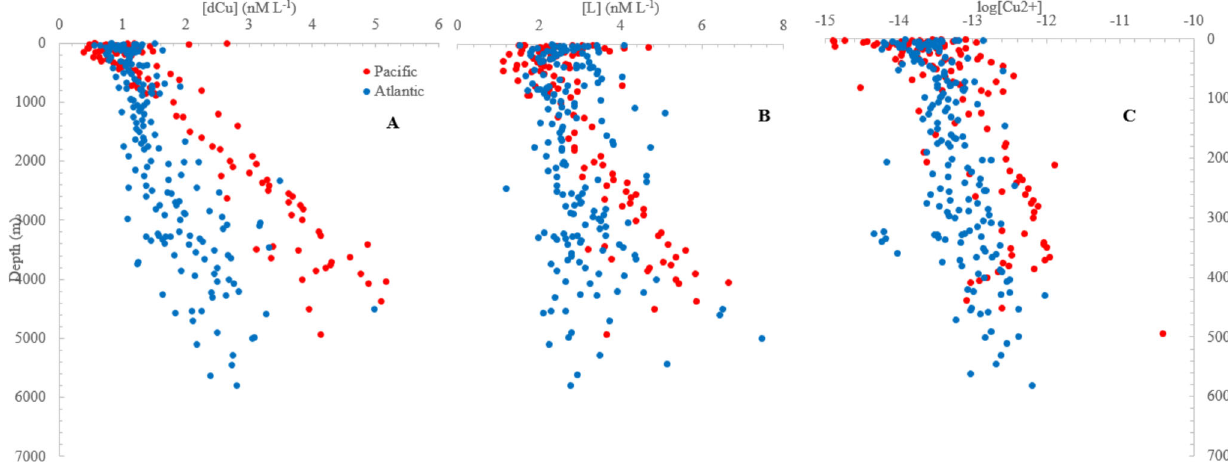
Fig. 3 Dissolved copper and ligand data for the North Atlantic and South Paci fi c Oceans. A Averaged dissolved Cu data for the Paci fi c and North Atlantic oceans. B Averaged Cu-binding ligand data for the Paci fi c and North Atlantic oceans collected from available datasets. C Averaged free Cu, log[Cu 2 + ], from available datasets for the Paci fi c and North Atlantic oceans